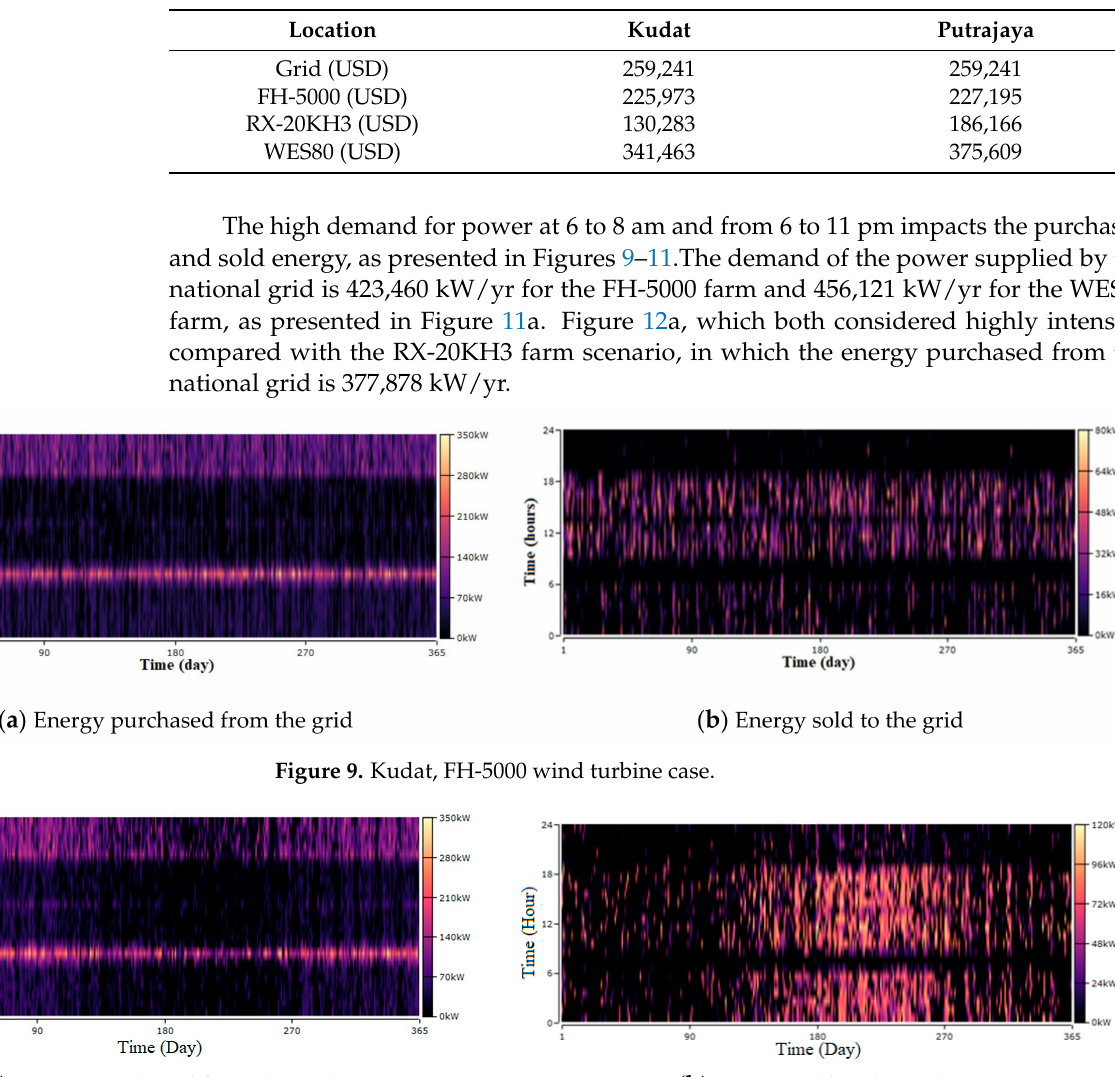
Table 2. Net present cost for each evaluated case.